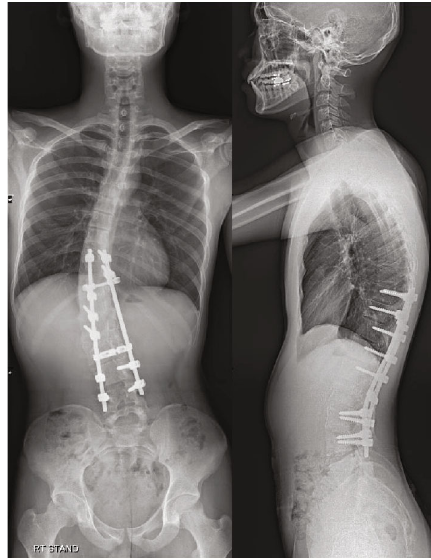
Figure 8: Whole spine plain radiograph at the follow-up visit to outpatient clinic, at March 11 th , 2019, 3 years and 4 months are passed since the